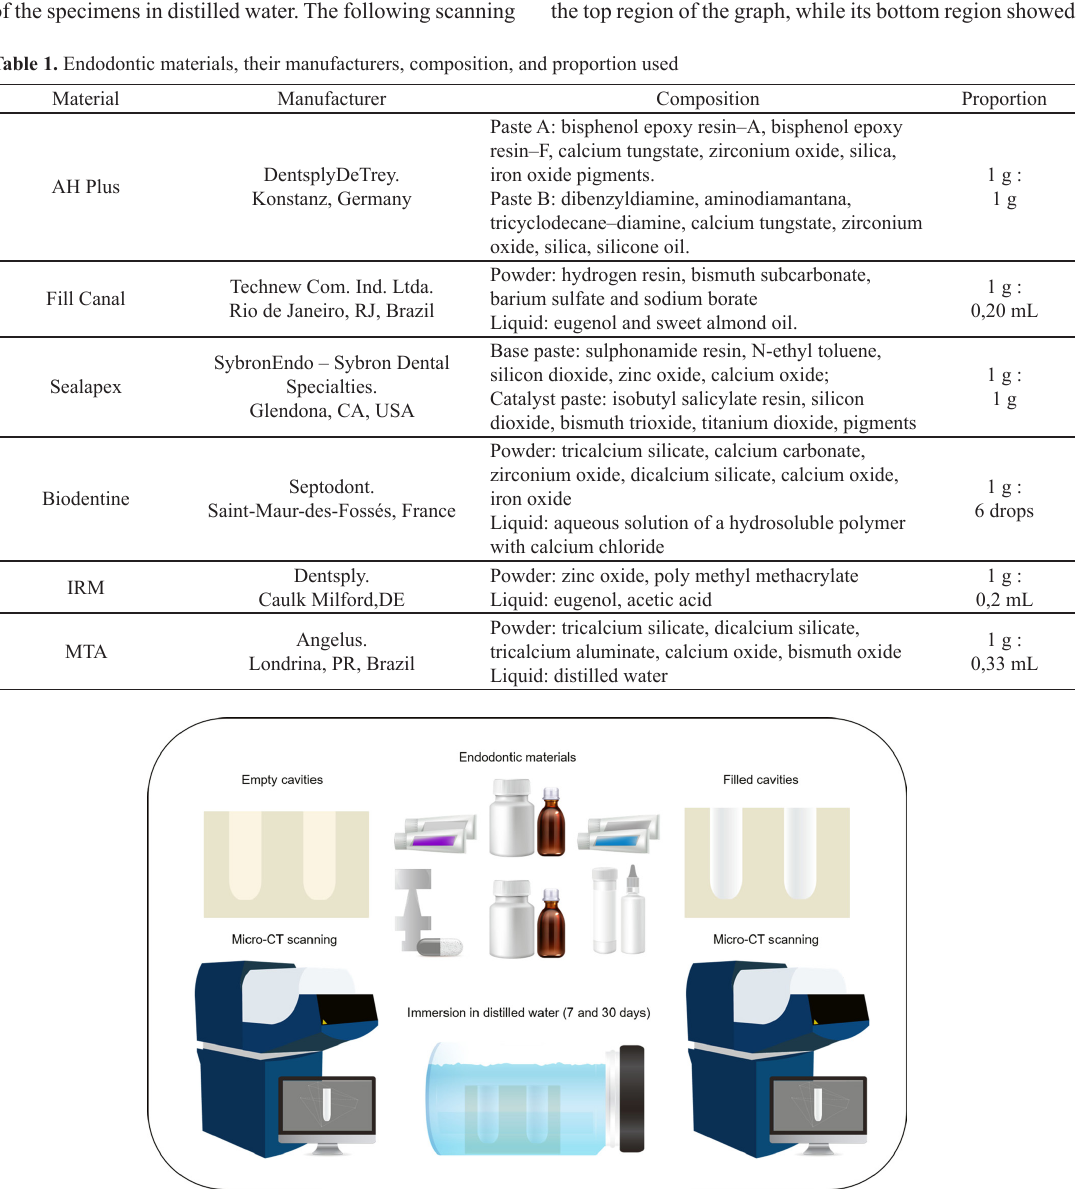
Figure 1 - Schematic figure representing the volumetric change assessment. Transparent acrylic resin-based models with cavities measuring 3 mm deep were filled with the different materials, and scanned in micro-CT after setting. The samples were scanned again after 7 and 30 days of immersion in distilled